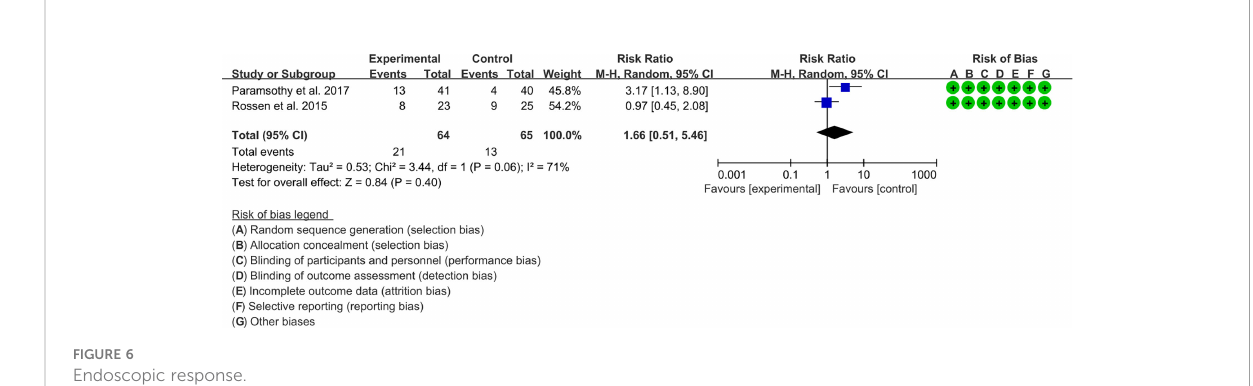
FIGURE 6 Endoscopic